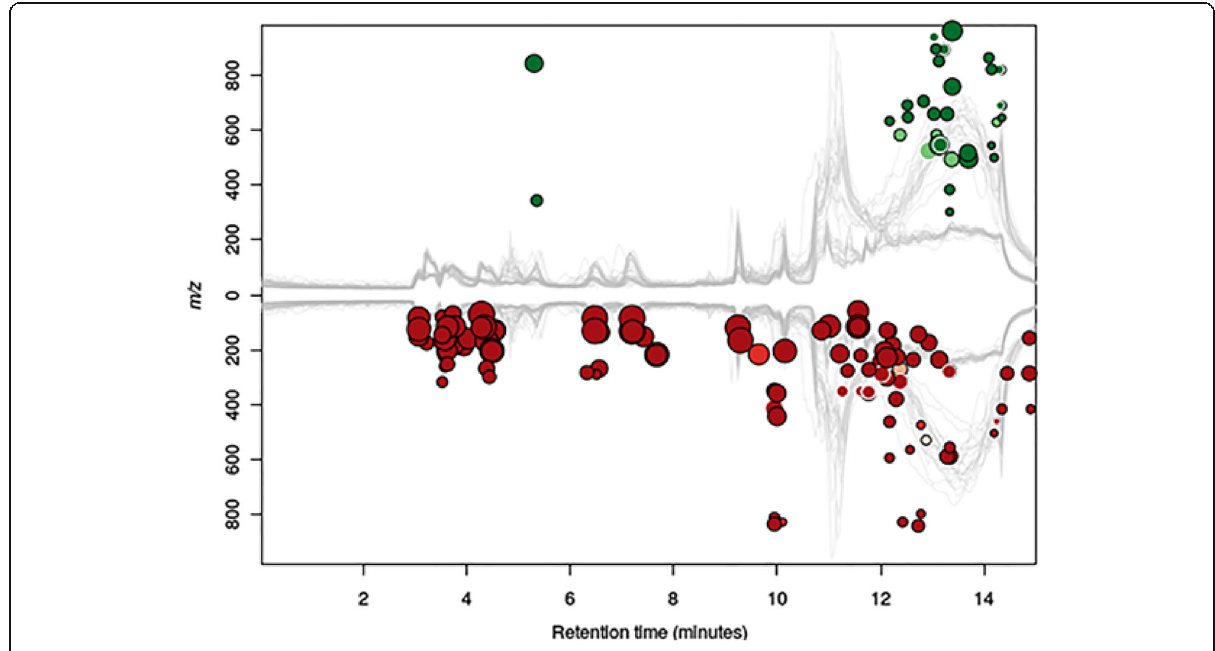
Fig. 1 Cloud plot of 163 different metabolites in patients with STEMI compared to NSTEMI ( p value ≤ 0.01, fold change ≥